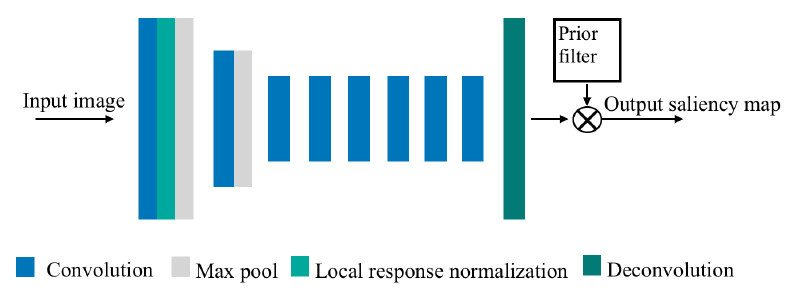
Figure 2. Deep neural network architecture of